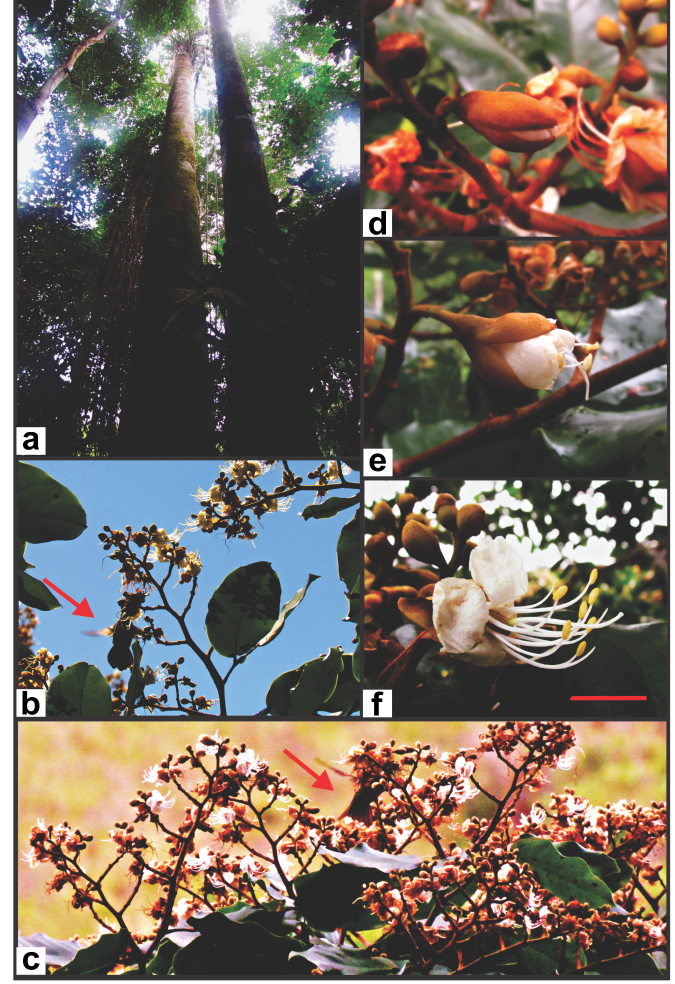
Figure 1. Hymenaea oblongifolia var. latifolia Lee & Langenh. in a fragmente of ombrophilous forest, Ibirapitanga, Bahia, Brazil. (a) Individual focal plant in its habitat; (b and c) Hummingbird (Hylocharis sapphrina) making contact with the anthers of H. oblongifolia var. latifolia during its visits (red arrow); (d, e and f) Sequence of anthesis of H. oblongifolia var. latifolia (floral bud at the beginning of anthesis, flower at the middle of the anthesis, and flower at end of anthesis, respectively). Red bar = 1